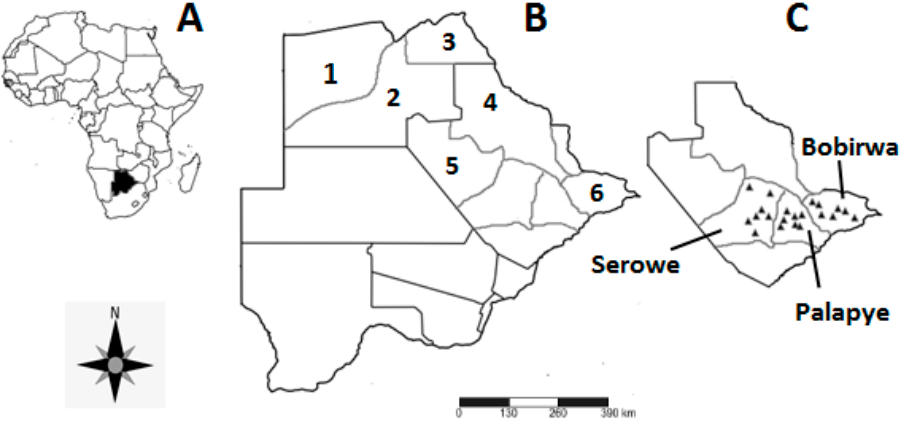
Figure 1. Map showing ( A ) the location of Botswana within Africa, ( B ) the malaria endemic sub-districts and the study site in Botswana, and ( C ) surveyed villages of the Central district; Serowe, Palapye and Bobirwa sub-districts. 1 = Okavango, 2 = Ngamiland, 3 = Chobe, 4 = Tutume, 5 = Boteti, 6 = Bobirwa.